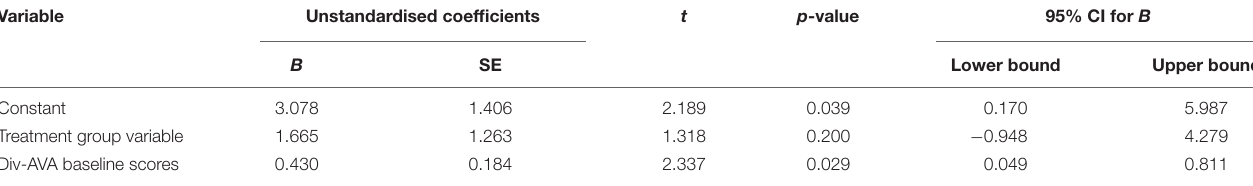
TABLE 8 | Unstandardised coefficients and their CIs, t -values, and p -values of each independent variable in the multiple regression model. Variable